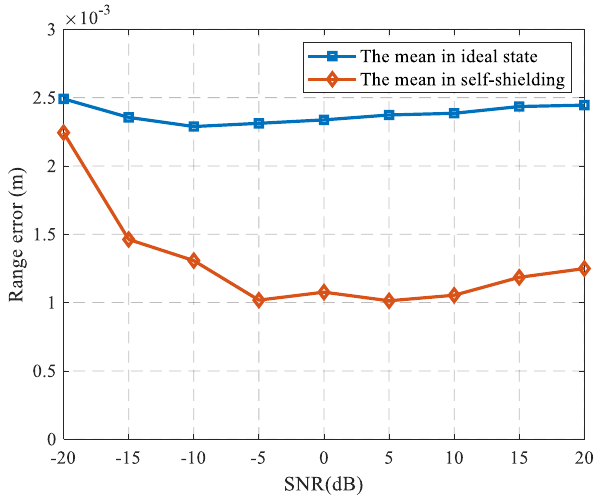
Figure 13. The mean of KF errors versus different SNRs.